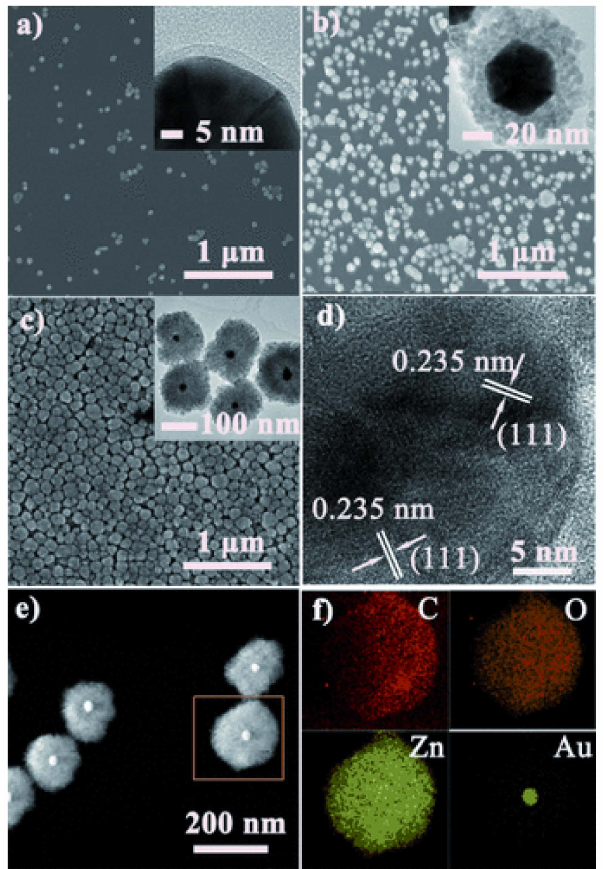
Figure 10. SEM and TEM (insets) images of the core–shell Au@MOF-5 NPs presenting shell thicknesses of ( a ) 3.2 ± 0.5 nm, ( b ) 25.1 ± 4.1 nm, ( c ) 69.0 ± 12.4 nm, ( d ) TEM image of a core–shell Au@MOF-5